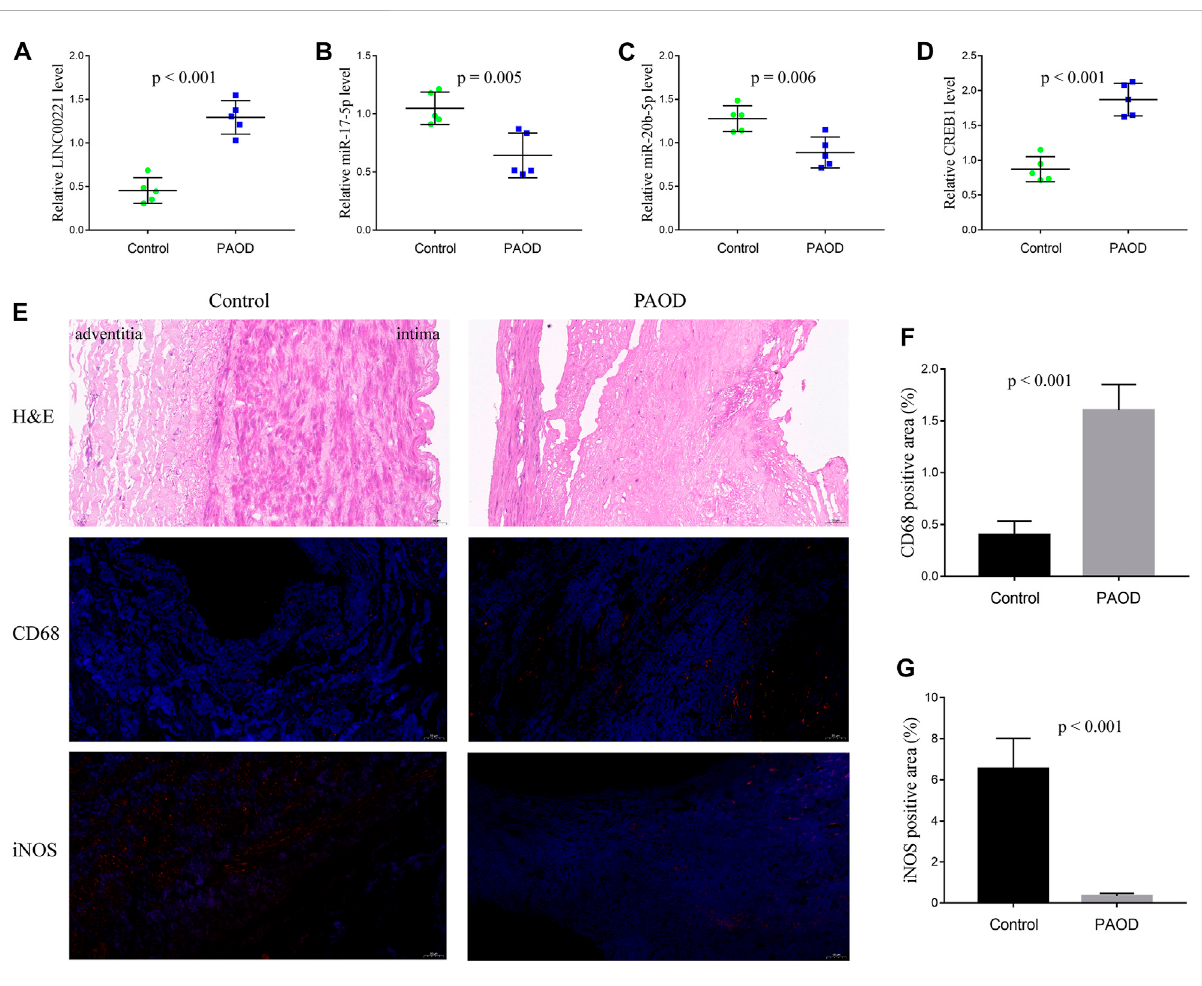
FIGURE 8 RT-qPCR validation of the immune-related core ceRNA network and evaluation of monocytes and M1 macrophages in tissue samples. Quanti fi cation of the relative expression levels of LINC00221 (A) , miR-17-5p (B) , miR-20b-5p (C) , and CREB1 (D) using RT-qPCR. (E) Representative pictures of H&E and immuno fl uorescence staining (magni fi cation, ×20). Quanti fi cation of molecules in CD68 (monocyte) Fig: (F) and iNOS (M1 macrophage) Fig: (G) positive